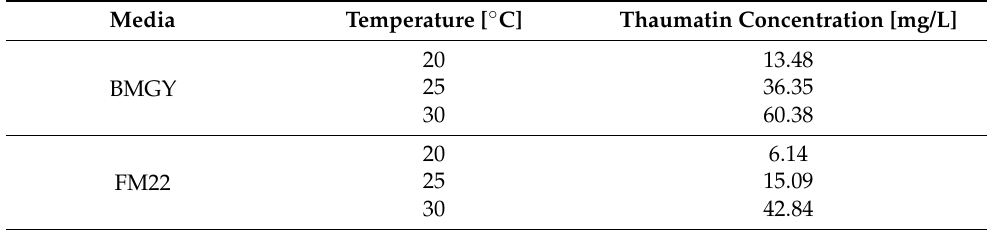
Table 4. Concentration levels of recombinant thaumatin II secreted into the media of induction pH 6.0 and grown at 20, 25 and 30 ◦ C as quantified using SDS PAGE densitometric analysis at the end of